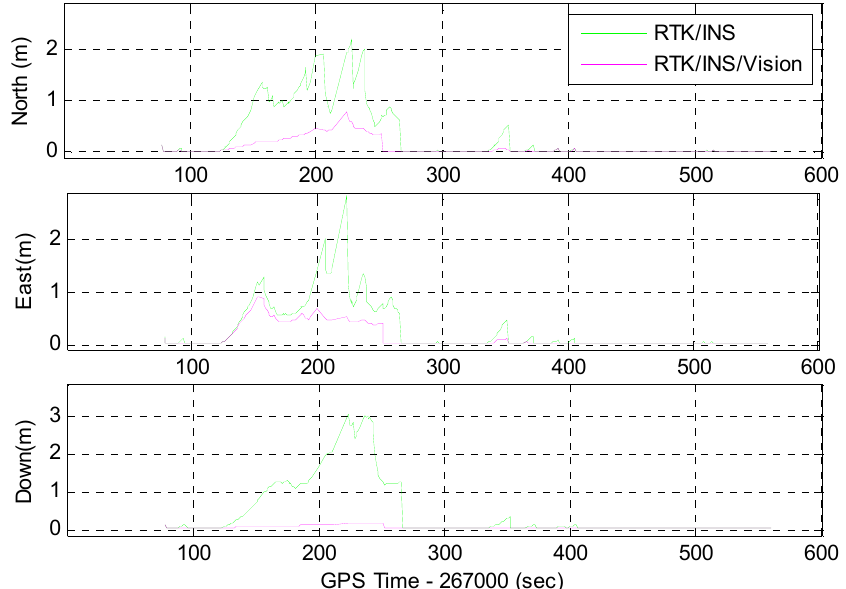
Figure 10. Position difference of the tightly coupled RTK/INS/Vision integration with respect to the reference for the GPS, GPS + BDS (G + C), and GPS + BDS + GLONASS (G + C + R) systems. Remote Sens. 2019 , 11 , x FOR PEER REVIEW